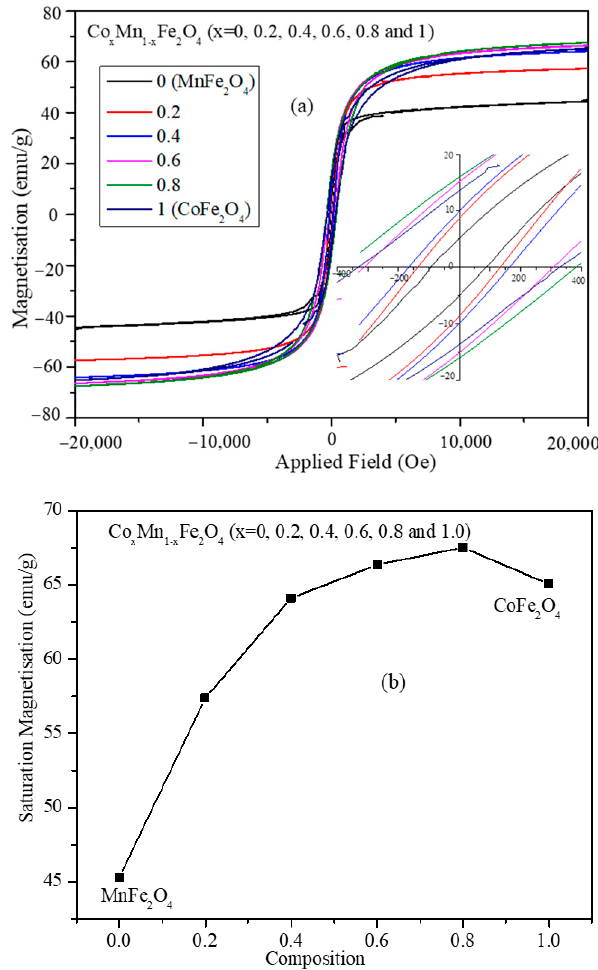
Figure 5. ( a ) Magnetic hysteresis loops obtained at room temperature in the field range of − 2.0 T to +2.0 T for Co x Mn 1-x Fe 2 O 4 ( x = 0.0, 0.2, 0.4, 0.6, 0.8, and 1.0) nanoparticles. ( b ) Mass normalized saturation magnetization (M s ) value vs. Co 2+ concentration of mixed ferrite (line in ( b ) is just a guide for the eye). Table 3. The coercive field and remnant magnetization of the nanoparticles obtained at room temperature. Composition Coercive Field